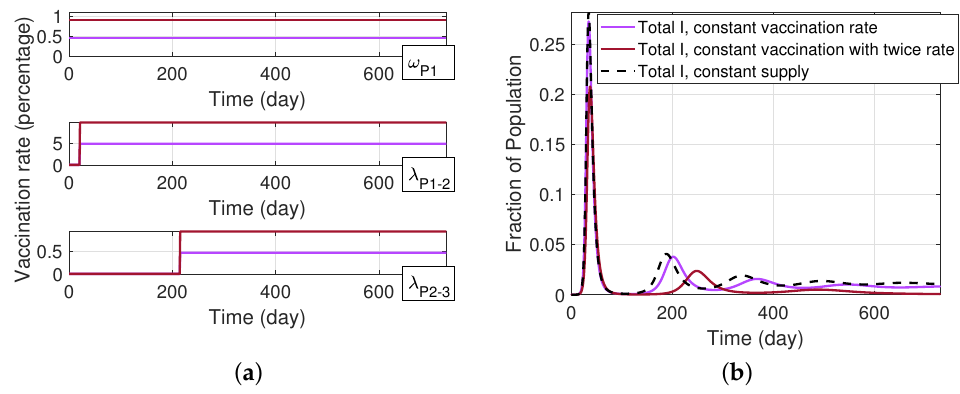
Figure 12. SIRS model with a three-dose vaccine and different vaccinated and unvaccinated compart- ments (model depicted in Figure 10), assuming that the vaccination with the Pfizer vaccine is available from the beginning with sufficient supply for vaccinating all groups; ( a ) constant vaccination rates of the first dose, second dose, and third dose from the top row to bottom row, respectively, each for two different values; ( b ) fraction of infectious